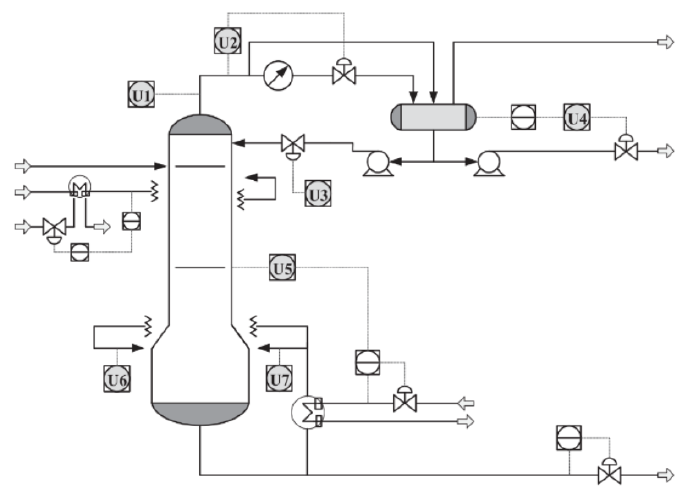
Figure 4. Schematic representation of the debutanizer column process